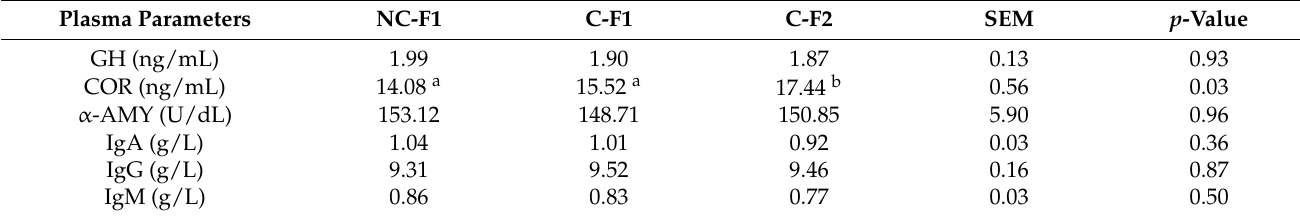
Table 4. Effect of different cross-fostering times on the plasma parameters of piglets.